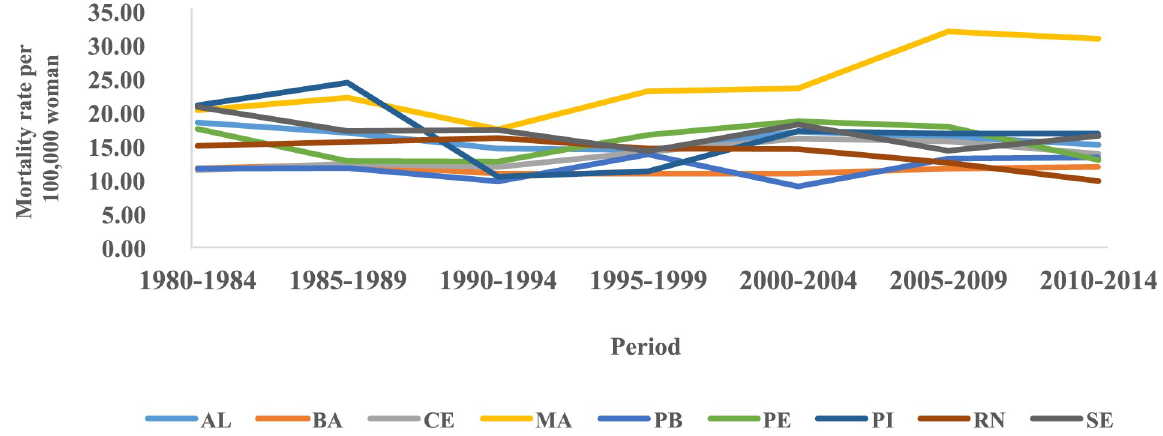
Fig 3. Mortality rates for cervical cancer in the Northeast region of Brazil, by period and age group, 1980 to 2014.